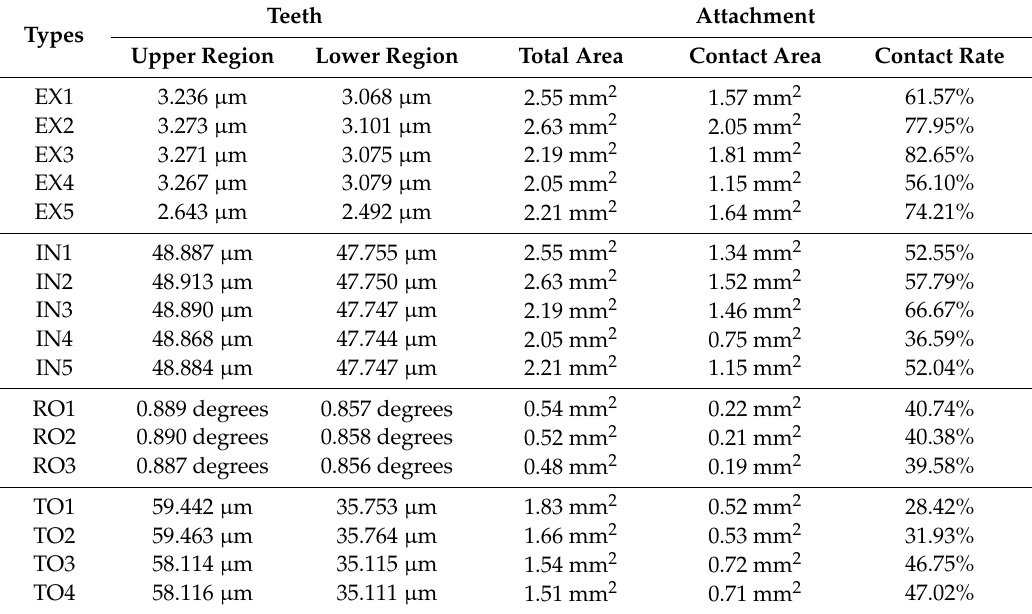
Table 4. Displacement and rotation values in the upper and lower regions, and contact area as well as contact rate in the attachment on the surface between the orthodontic device and attachment in four types of orthodontic treatment